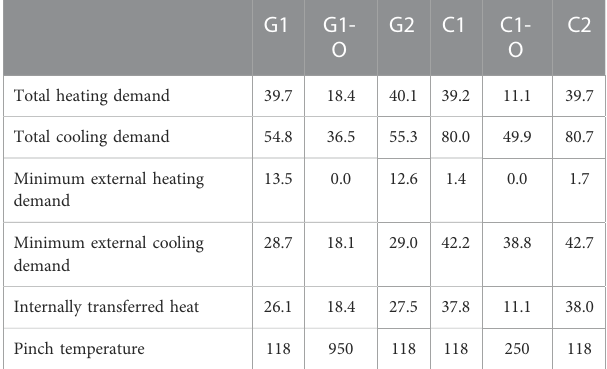
TABLE 7 Scenario heat balances following heat integration: heating and cooling demand (MW) and pinch temperature ( ° C).